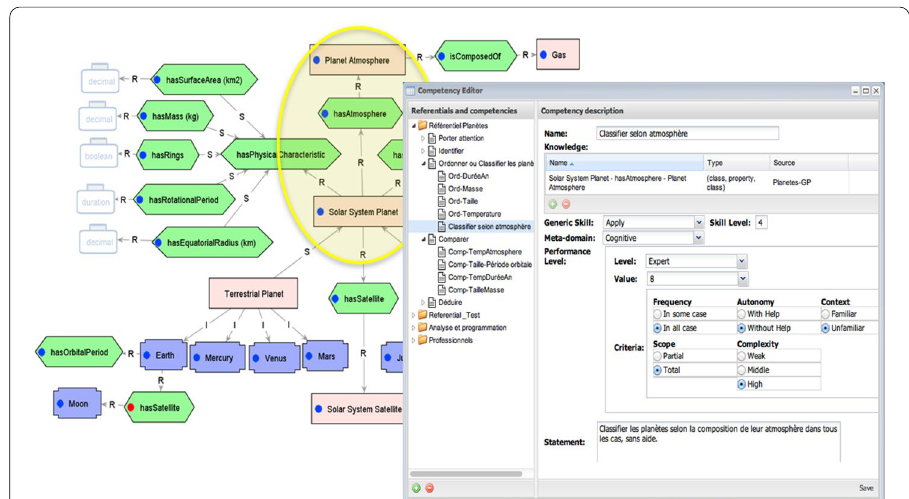
Fig. 9 Building a competency referential for an astronomy